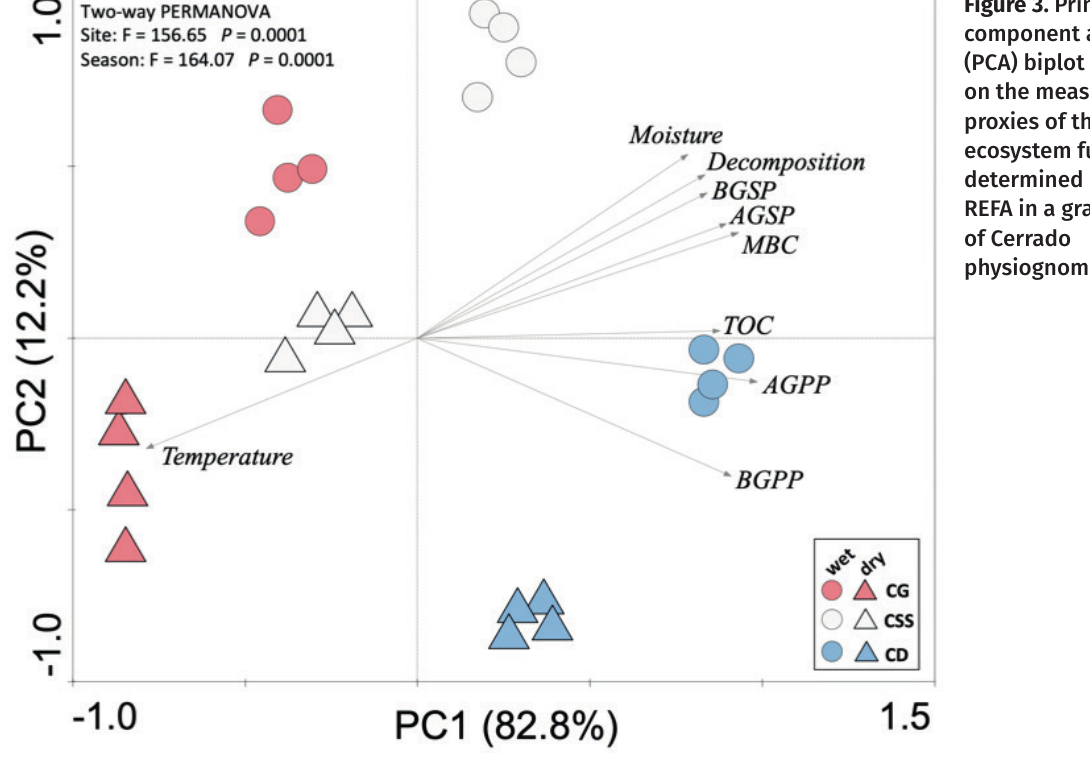
Figure 3. Principal component analysis (PCA) biplot based on the measured proxies of the ecosystem functions determined by REFA in a gradient of Cerrado